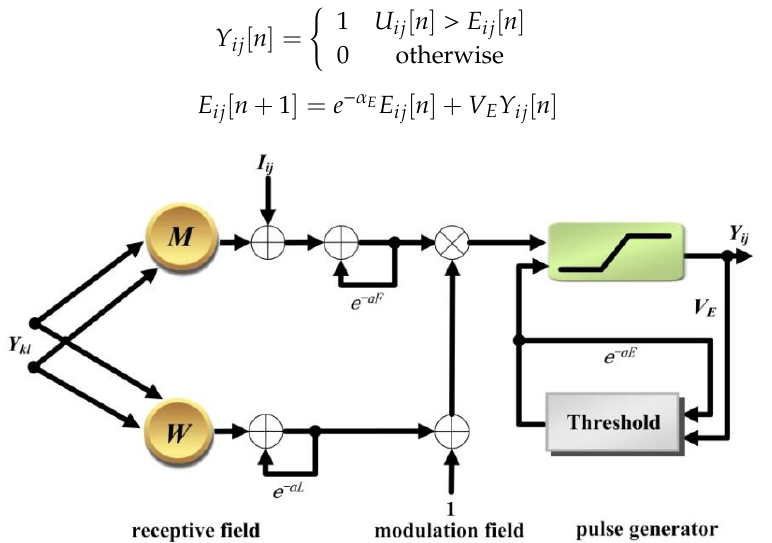
Figure 2. Structure of standard PCNN model.